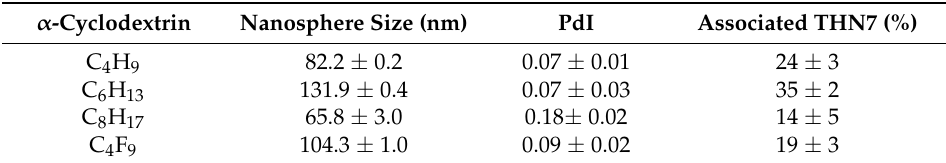
Table 2. Mean diameter (nm) and polydispersity index (PdI) of nanospheres based on different amphiphilic α -cyclodextrins and % of associated THN7.